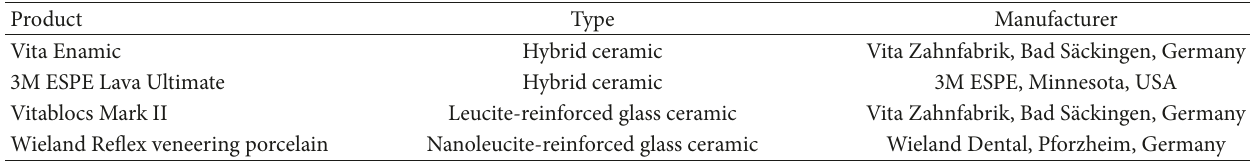
Table 1: Ceramic materials tested in this